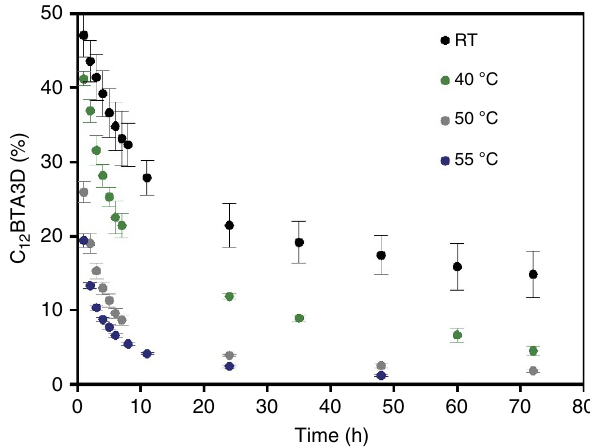
Figure 4 | Temperature-dependent exchange kinetics. Percentage of C 12 BTA3D over time when equilibrated at room temperature (black circles), 40 (cid:2) C (green circles), 50 (cid:2) C (grey circles) and 55 (cid:2) C (blue circles). The error bars represent one s.d. of uncertainty computed from three separate kinetic experiments.